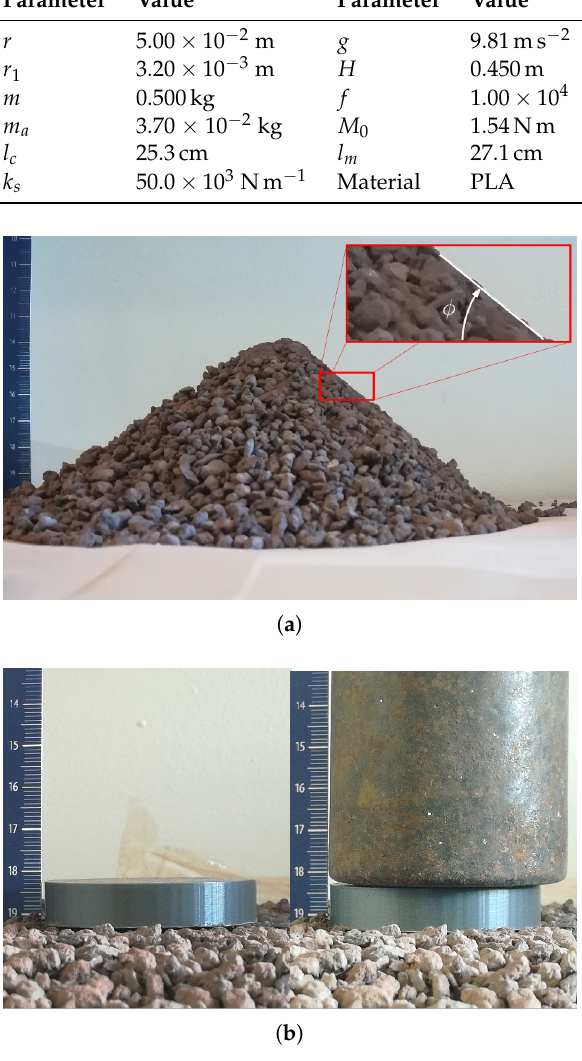
Figure 4. Experimental characterization of the soil: ( a ) measure of the internal angle φ ; ( b ) measure of the penetration depth. The scale unit is centimeters in both